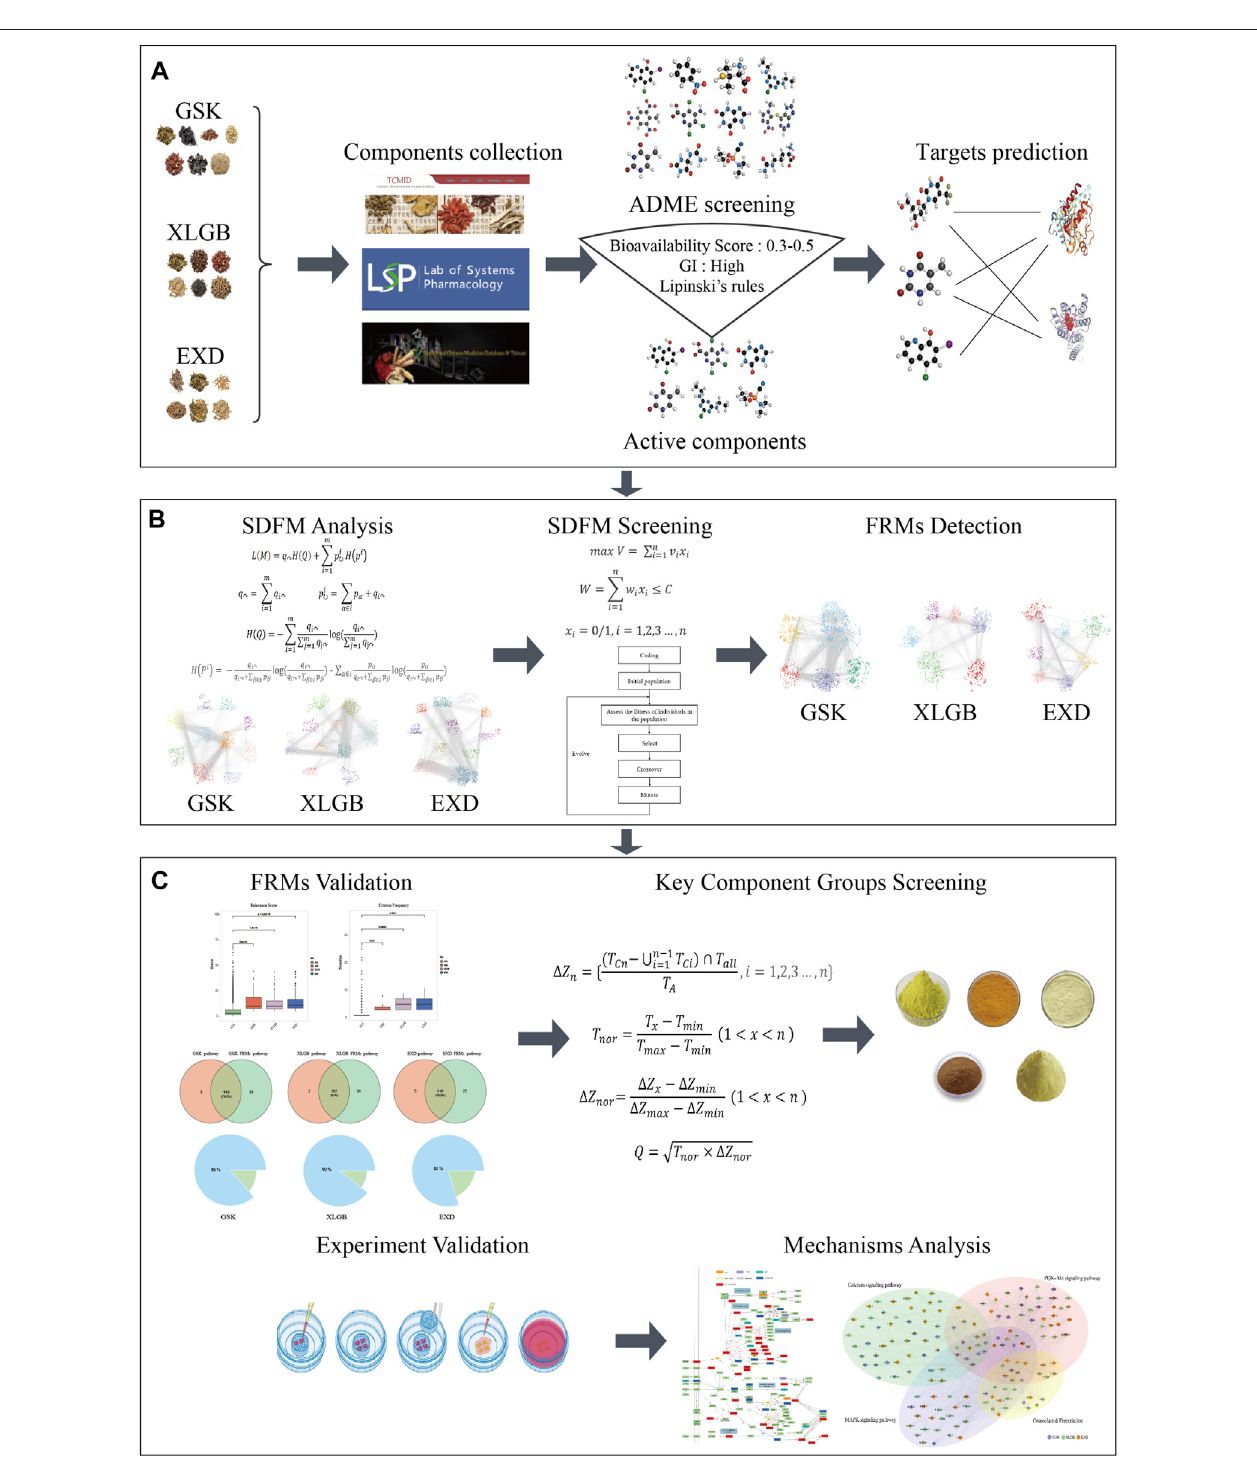
FIGURE 1 | The fl owchart of our network pharmacology approach, including component collection and target prediction (A) . Using the function motif discovery model to fi nd Signi fi cant Different Functional Modes (SDFMs) in the three prescriptions and then using the genetic-based optimization model to fi gure out the Functional Response Motifs (FRMs) (B) . Validation of FRMs, screening key component groups, and experiment validation and potential mechanism analysis (C) .